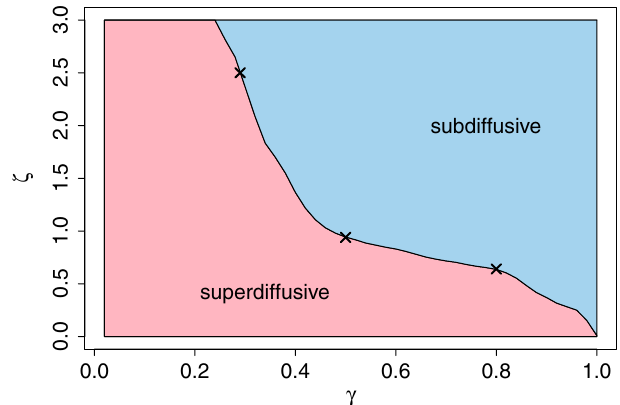
FIG. 3. Comparison of the stationary density of the book with the expected shape calculated from Eq. (5). The symbols show the empirical shape of the book from the simulations, while the solid line shows the predicted exponential form, with u (cid:7) being computed from the actual price volatility. In the simulations we used the parameters, (cid:10) ¼ 0 : 8 , (cid:11) ¼ 0 : 65 , (cid:5) 1 ¼ 10 (cid:2) 4 , (cid:4) ¼ 0 : 5 . The analytical computations lead to u (cid:7) ¼ while a direct fit to Eq. (5) leads to u (cid:7) (cid:1) 0 : 48